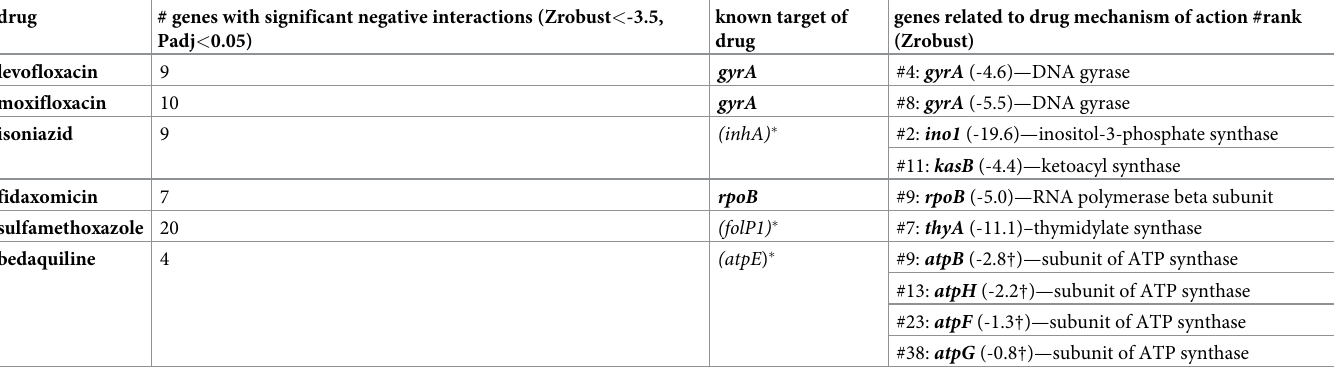
Table 4. Summary of interactions of relevant genes for various drugs in hypomorph library with 162 essential genes.